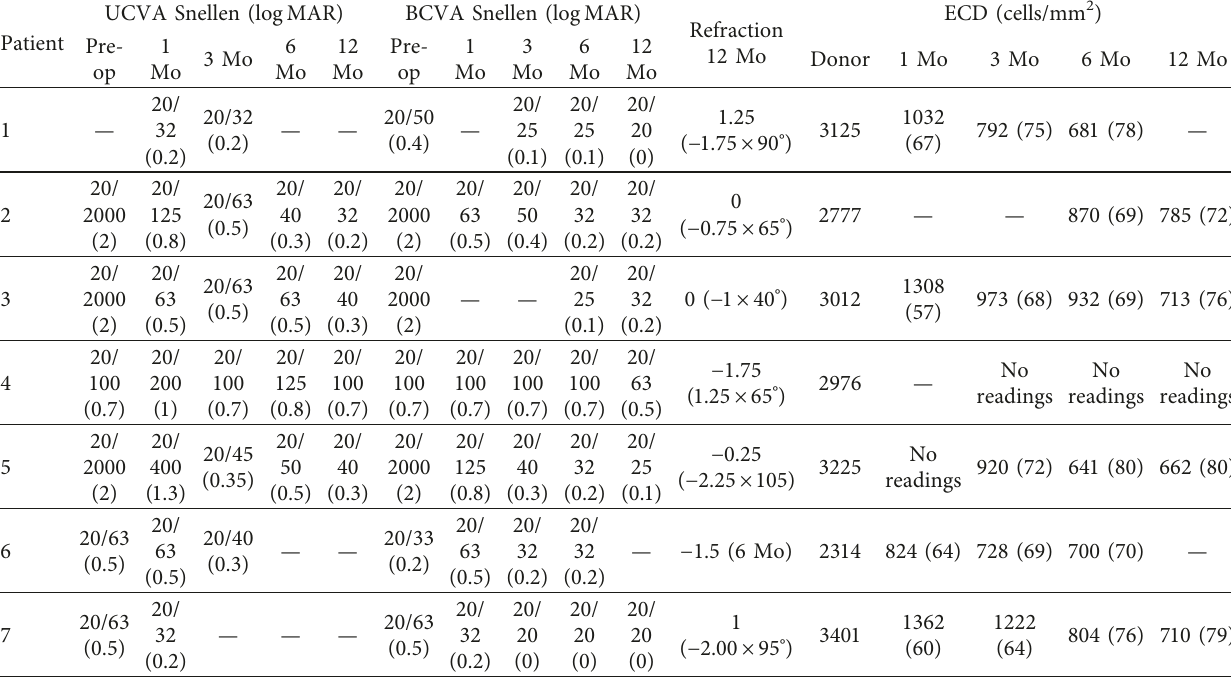
Table 2: Preoperative and postoperative outcomes of the seven